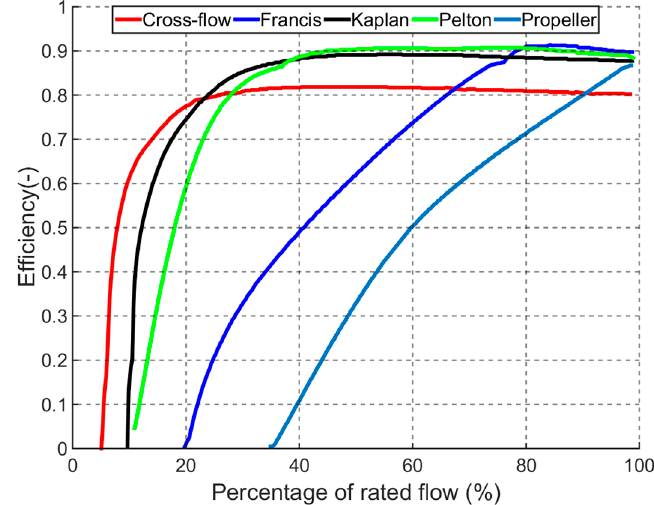
Figure 3. Efficiency curve of various turbine designs per percentage of rated flow [18].